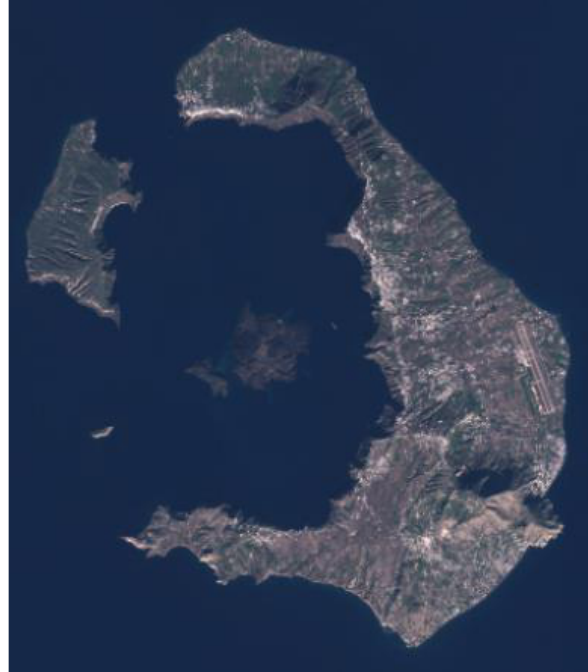
Figure 3. Sentinel-2 raw orthoimage